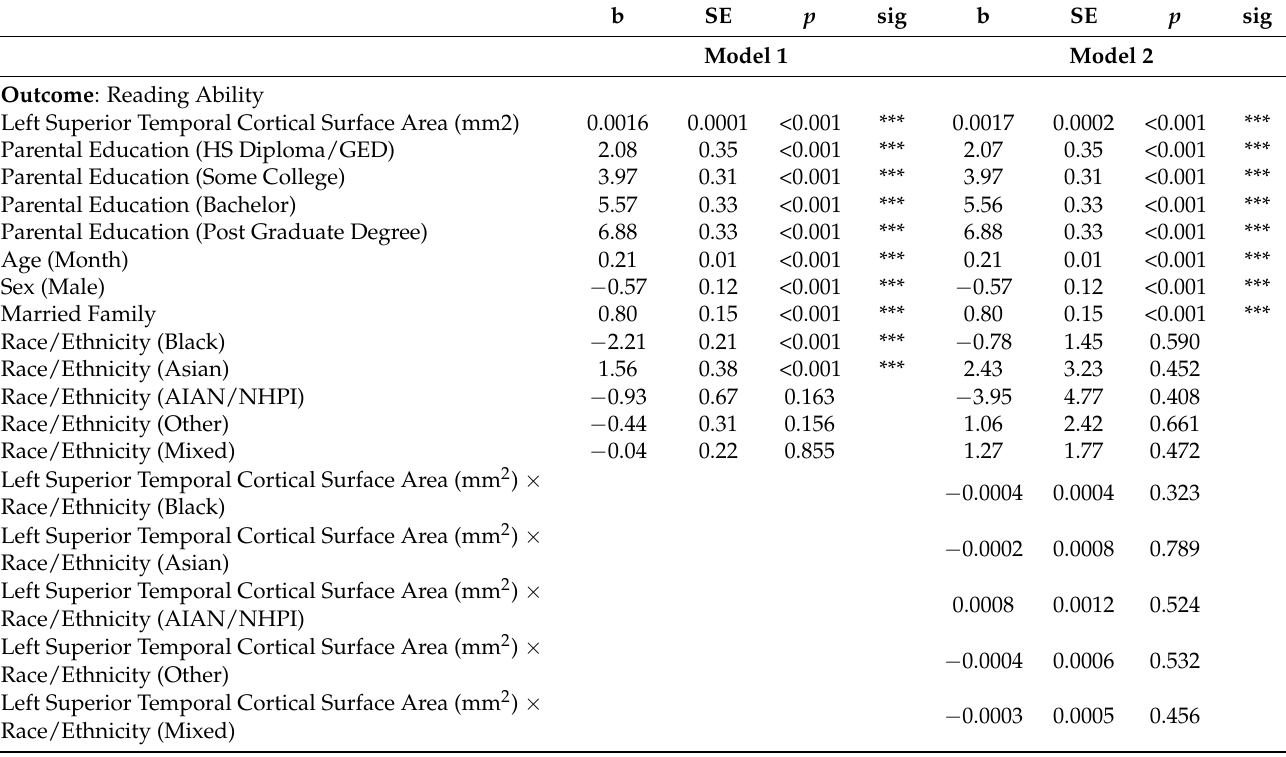
Table 6. Summary of mixed-effects regression models on the association between the left superior temporal cortical surface area and reading ability.